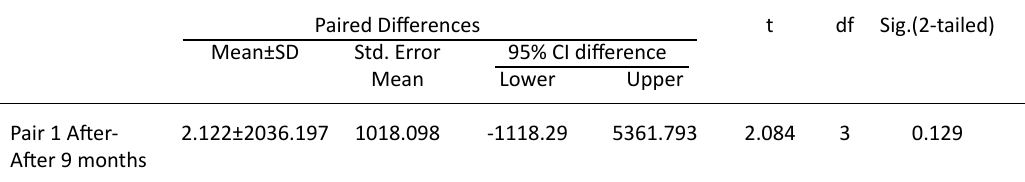
Table 3. Significance of differences in outcome of the antimicrobial effects Paired Differences